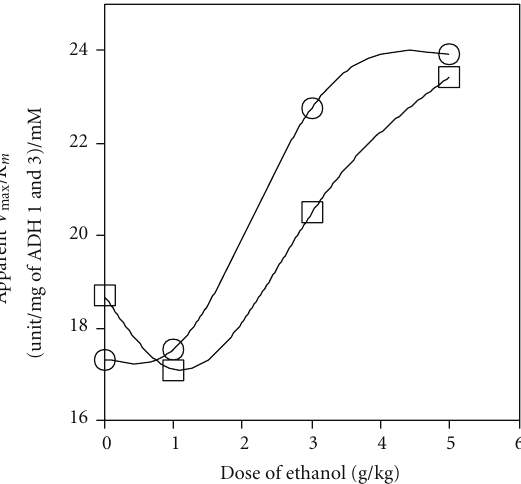
Figure 5: E ff ect of ethanol dose on catalytic e ffi ciency ( V max /K m ) of liver ADH activity. The apparent V max and K m of liver ADH activity were measured using liver extracts from mice 1 h ( (cid:2) ) and 4h ( (cid:2) ) after the administration of each dose of ethanol. V max is expressed per mg of the sum of the ADH 1 and ADH 3 contents. Each plot represents the average value of 3 mice.